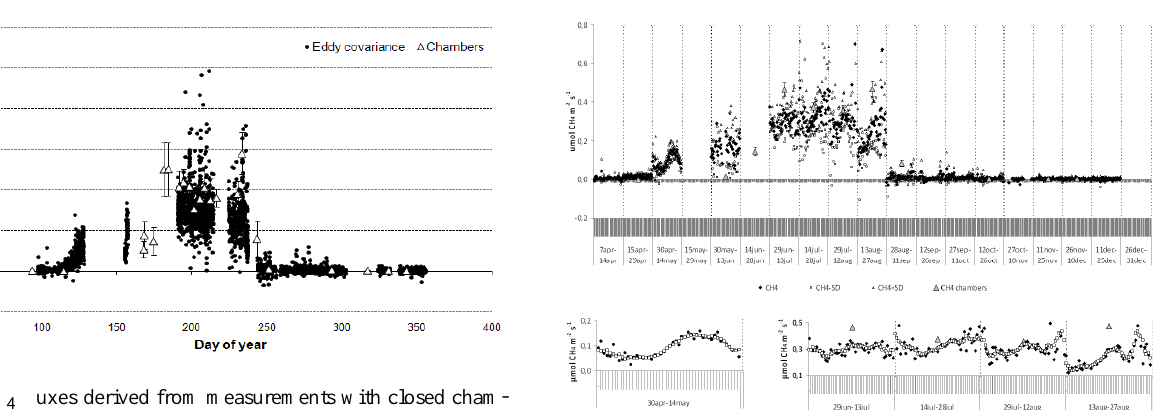
Fig. 3. CH 4 fluxes derived from measurements with closed cham- bers (open triangles) and eddy covariance.